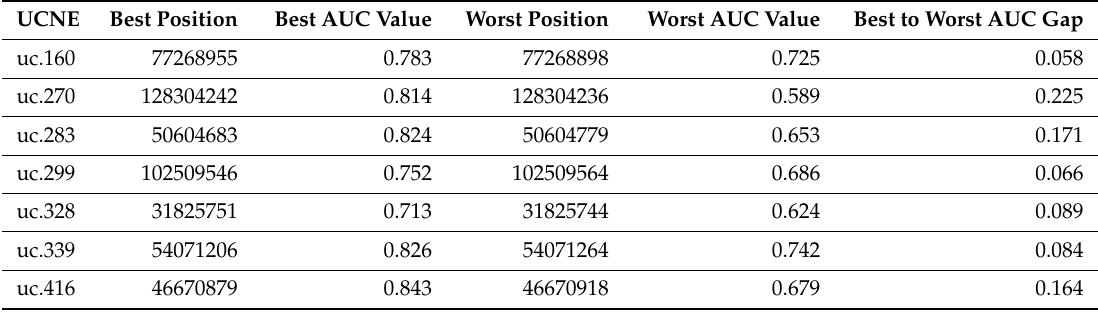
Table 3. Best and worst AUC values for all the seven UCNEs; the number indicates the position on the genome taking into account hg38 as a